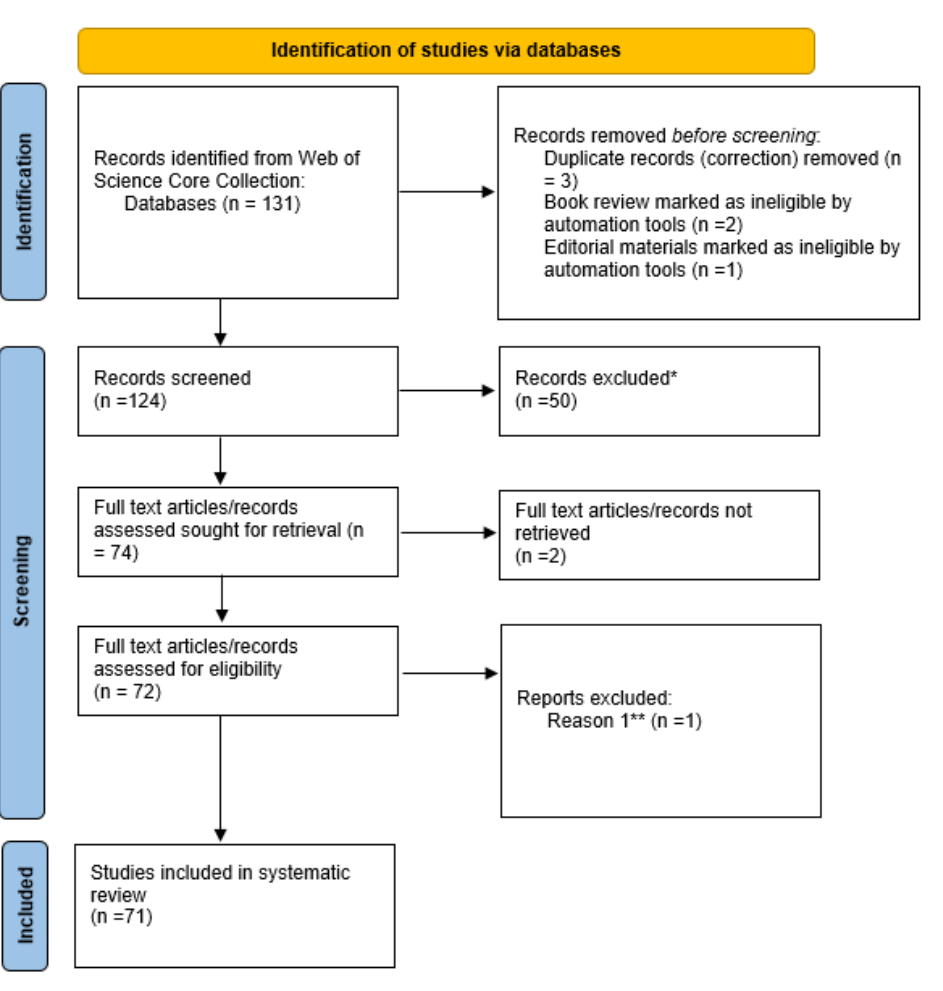
Figure 1. Preferred Reporting Items for Systematic Reviews and Meta-Analyses (PRISMA) analysis flow, which deals with sustainable ports. * The exclusions correspond to the articles that were removed after reading abstracts. Article does not apply to sustainable ports. ** The exclusions correspond to the articles that were removed after reading full text. Article does not apply to sustainabil- ity.